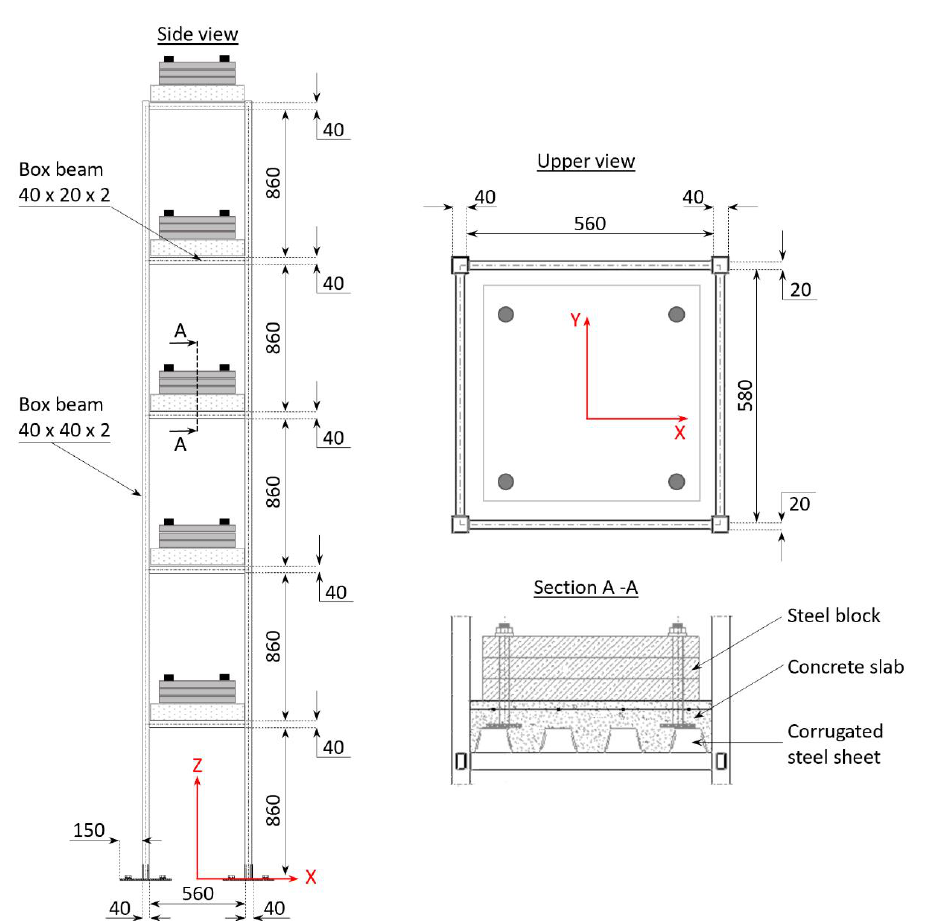
Figure 1. Reference structure, layout, and main dimensions (mm).